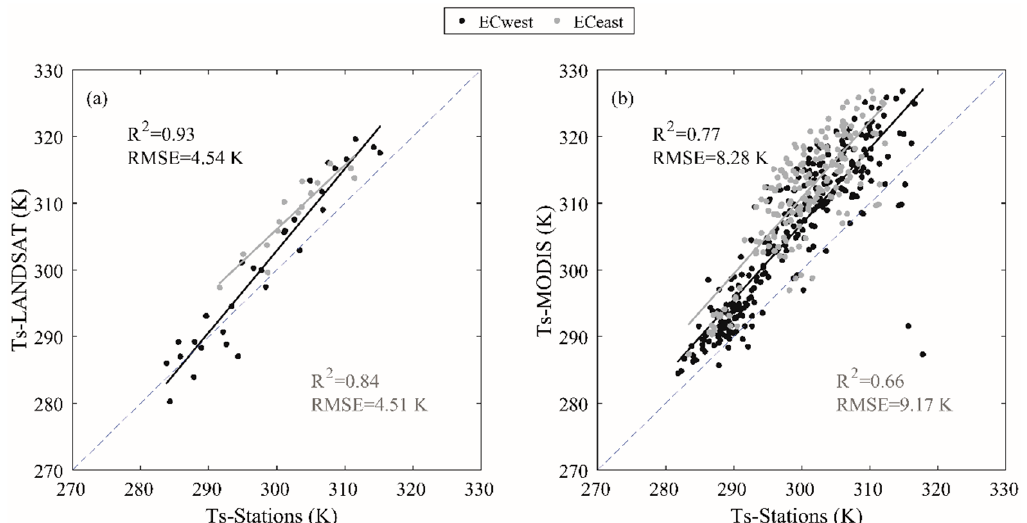
Figure 6. Scatterplot of Landsat LST ( a ) and MODIS LST ( b ) versus in situ data.